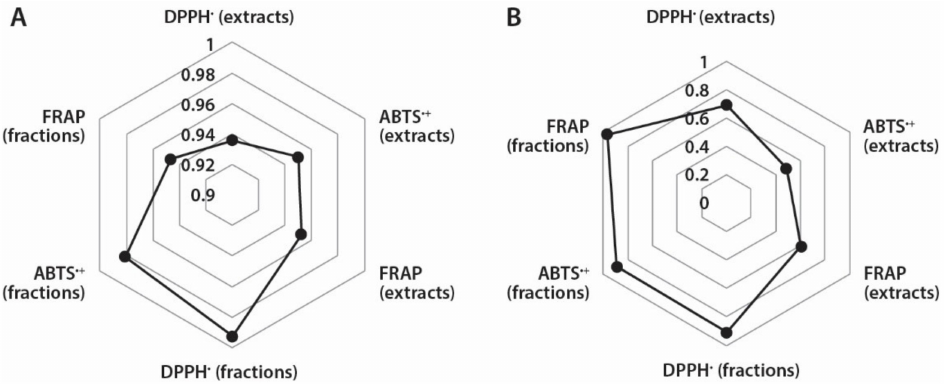
Figure 4. Correlation coe ffi cients between: ( A ) TPC and di ff erent antioxidant measurement assays and ( B ) mangiferin content and di ff erent antioxidant measurement assays in extracts and